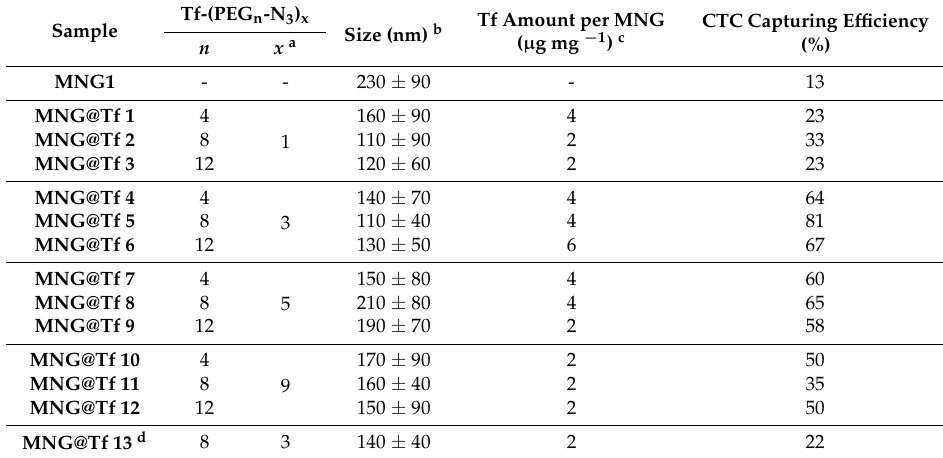
Figure 2. MNGs@Tf synthesis by ultrasound-assisted nanoprecipitation and its functionalization by quenching with PEG-azido-modified Tf. Table 1. Size, Tf amount and circulating tumor cell (CTC) capturing efficiency in an artificial CTCs suspension (HCT 116) for all MNG@Tf.